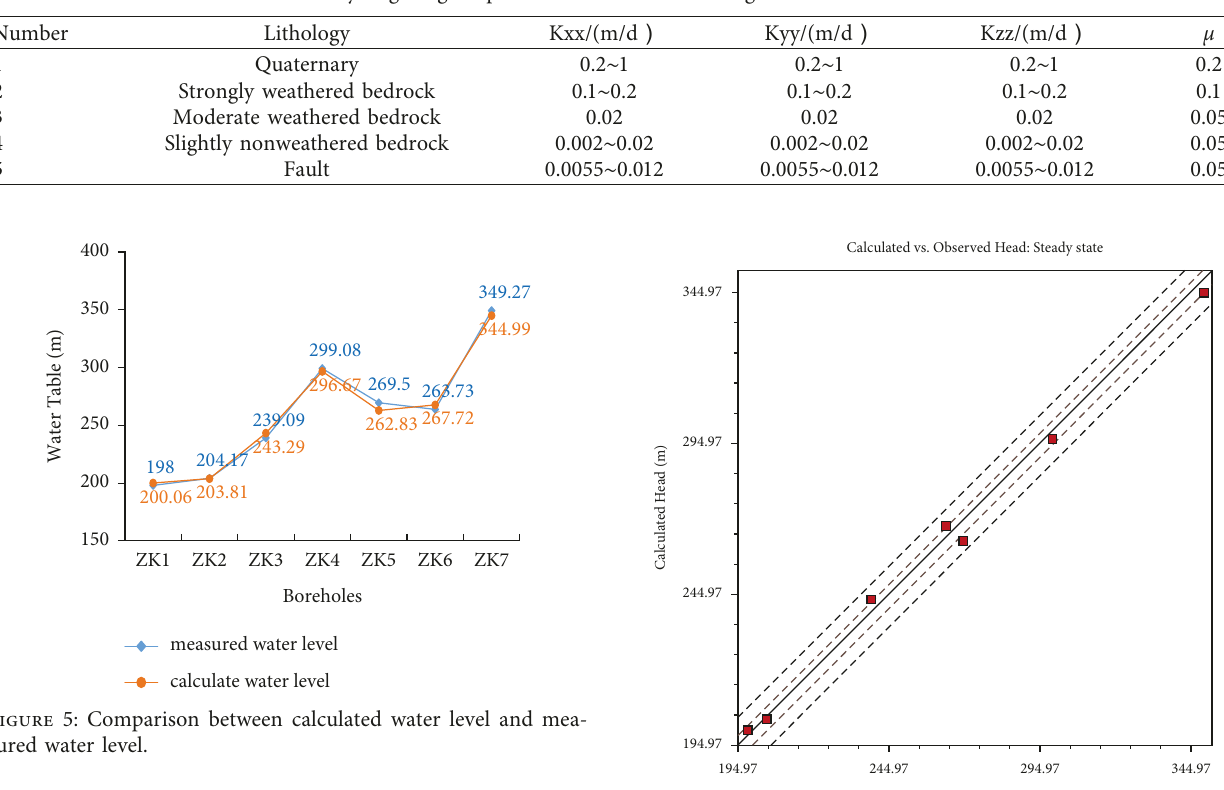
Figure 4: Digital elevation model of the study area. Table 2: Hydrogeological parameters of the validated groundwater flow model.